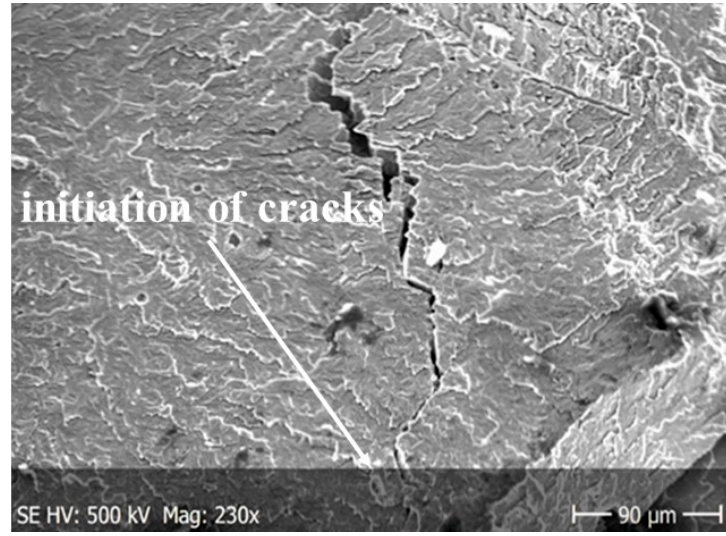
Figure 11. Initiation of cracks in cyclic tests.